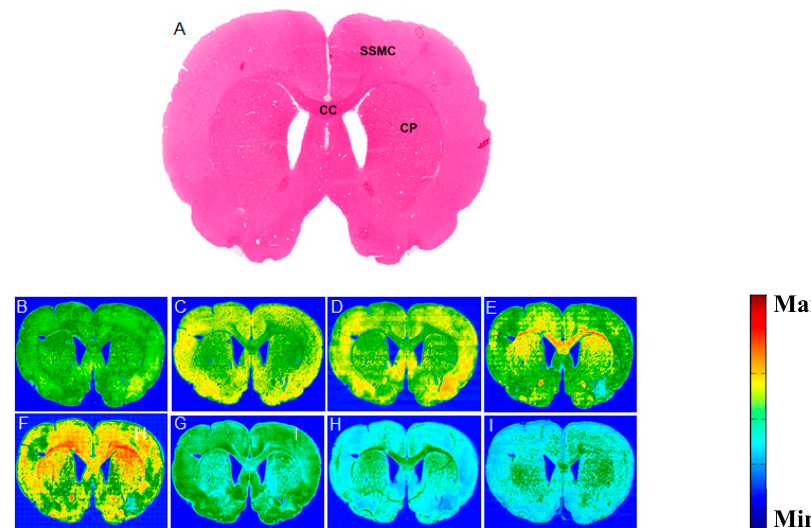
Figure 1. ( A ) H&E staining section of the rostral brain ( Bregma 1.56 mm ) showing the three regions of interest (ROI): SSMC, CC, and CP. ( B ) Corresponding FTIR image. ( C – I ) Representative images of the biochemical components—Amide I, Amide II, CH 3 asymmetric, CH 2 symmetric, CH 2 asymmetric, Olefin, and Ester, accordingly. The color bar represents a high concentration, in red, and low concentration, in blue.